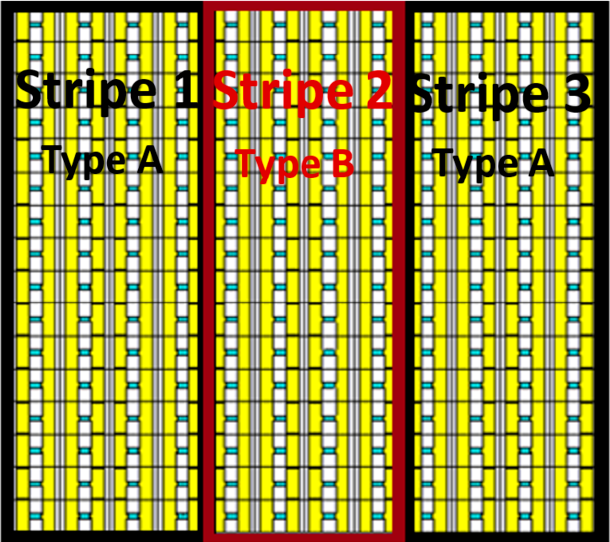
Figure 2. MS structure with three stripes stuck together.